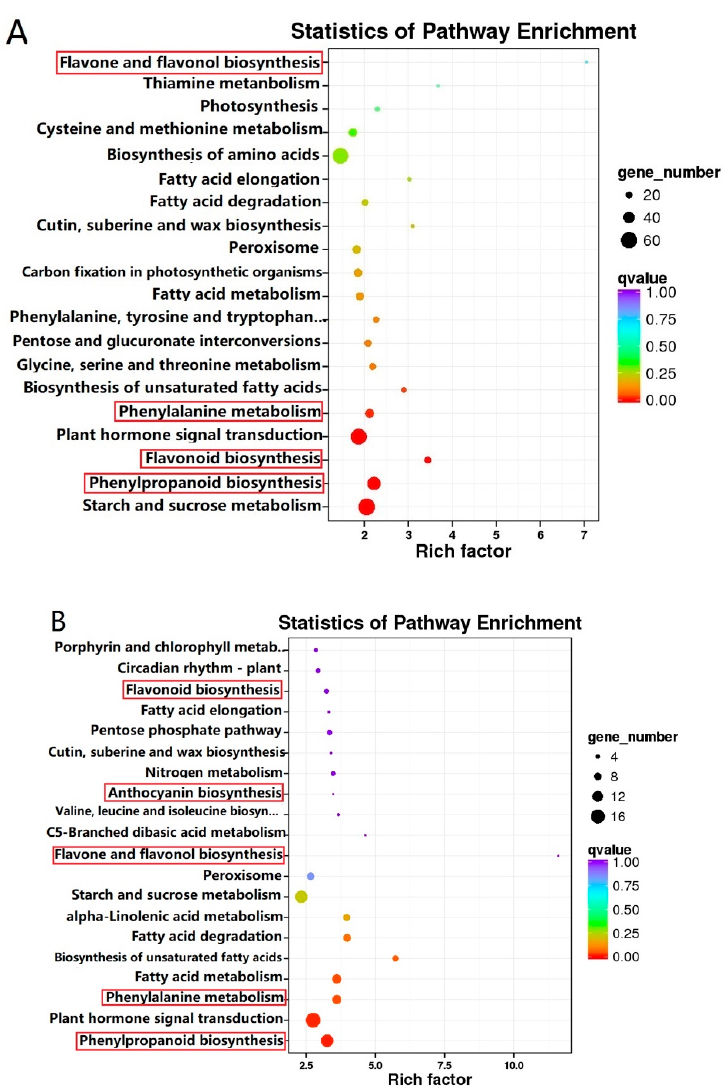
Figure 5. Results of top 20 KEGG enriched pathways in white ( A ) and pink ( B ) tea flower development stages. Q-value is a p-value that has been adjusted for the false discovery rate (FDR). A lower q-value indicates that a lower percentage of significant results will be false positives. Rich factor represents the degree of enrichment (i.e., over-representation) of genes under the designated pathway term. Greater the value of the rich factor, greater is the degree of pathway enrichment.